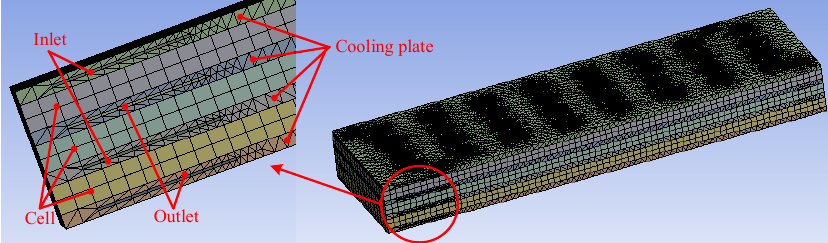
Figure 6. Grid display.